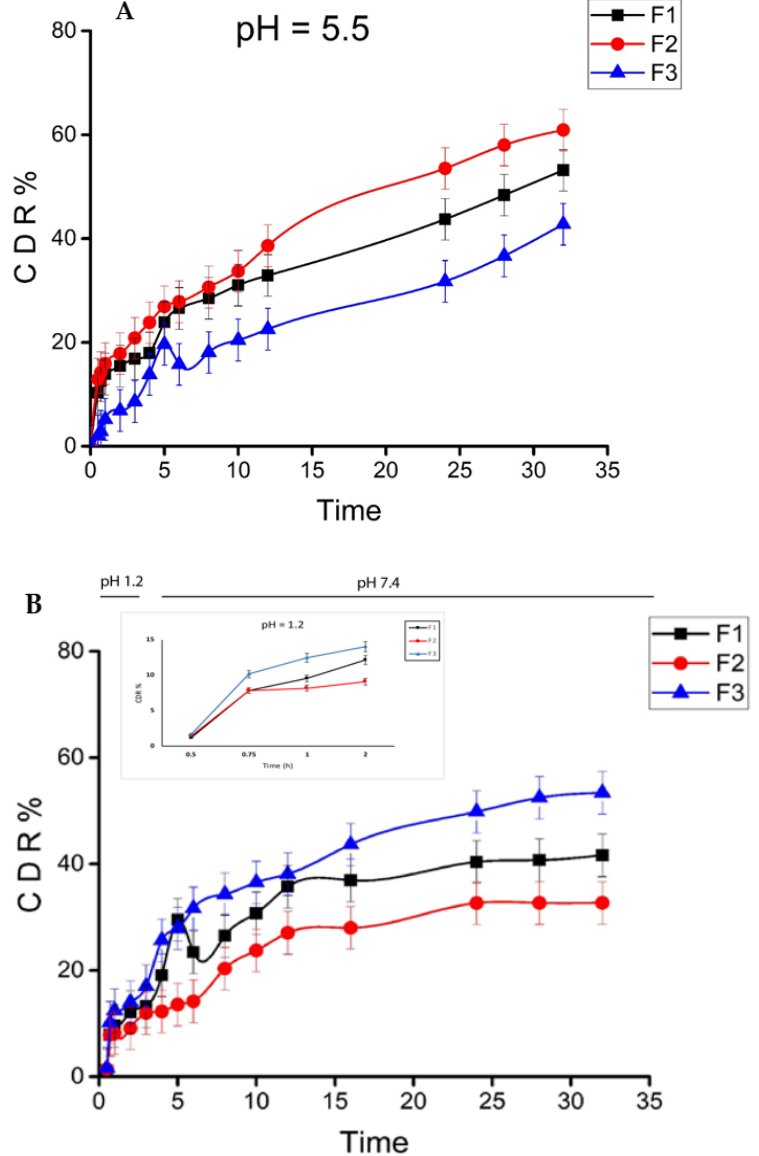
Figure 4. In vitro cumulative drug release percentage (CDR %) of MTX loaded AEM-CS nanoparticles. ( A ) pH 5.5, ( B ) 1.2 and 7.4 at 37 °C. (n = 3/ Mean ± S.D.).